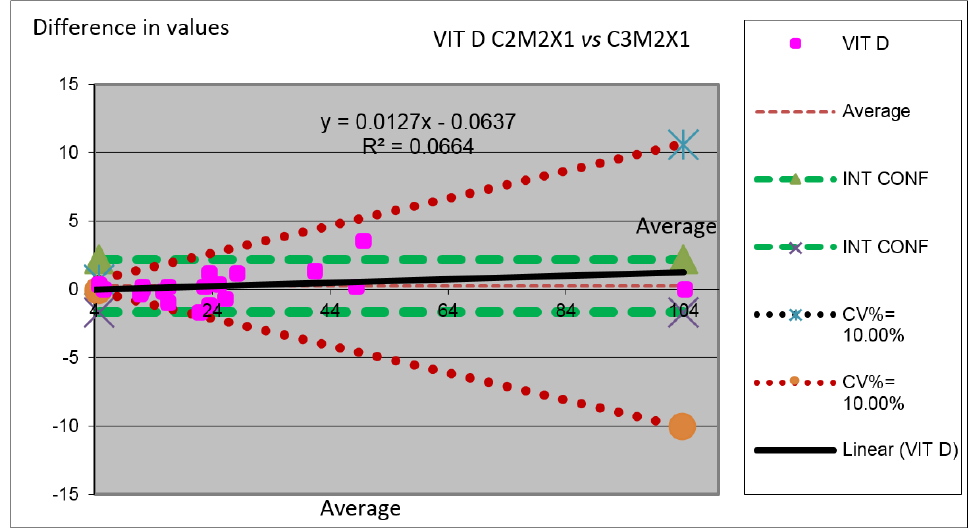
Figure 9. Comparison between modules for the Vitamin D parameter in which we have compared the results obtained by the measurements performed in the two machines (Analyzer C3 substituted by C2 in which the Module 2 is substituted by the Module M2 and the Channel X1 is substituted by the Channel